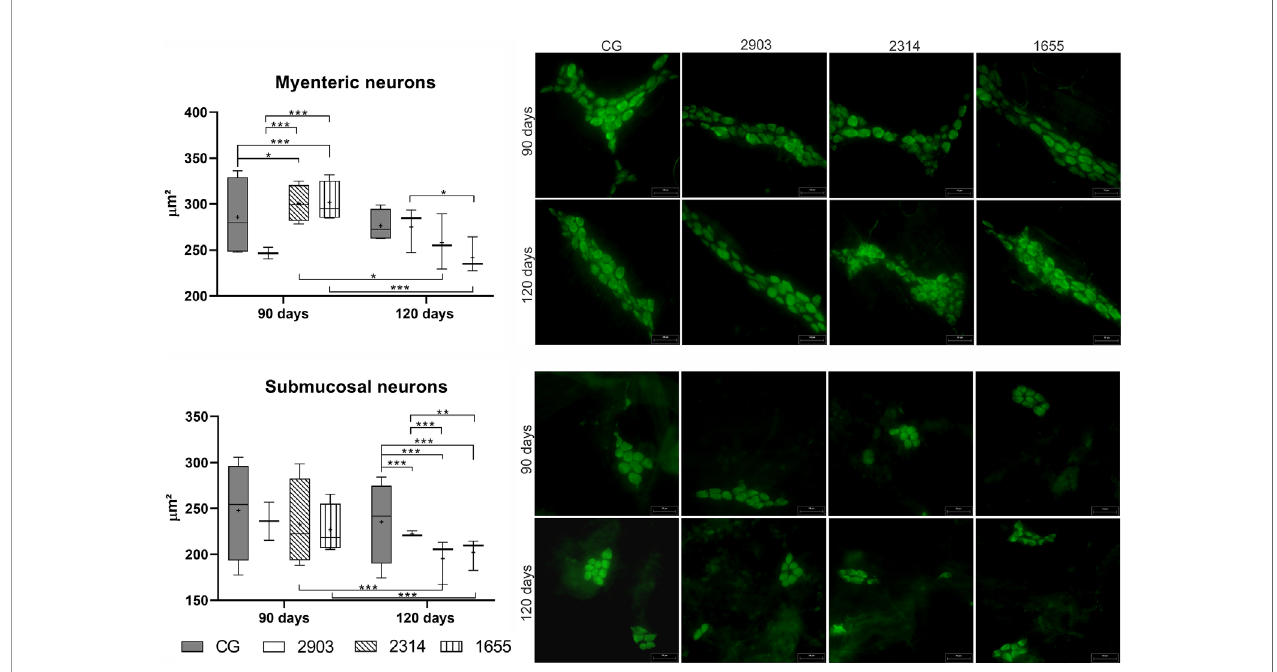
FIGURE 11 | Size of neuron bodies (μm²) in the myenteric and submucosal plexuses of ileums of hamsters infected by L. (V.) braziliensis for 90 or 120 days. Data represented in box plots (median with 25 to 75 percentile), whiskers (2.5 to 97.5 percentile), and mean (+) ( n = 4). * p < 0.05; ** p < 0.01; *** p < 0.001. Photomicrograph of neurons from both plexuses (HuC/HuD immunohistochemistry, 20× magni fi cation, scale bar = 50 μm, Olympus FSX100). CG, control group. 2903: group infected with MHOM/BR/1975/M2903. 2314: group infected with MHOM/BR/2003/2314. 1655: group infected with